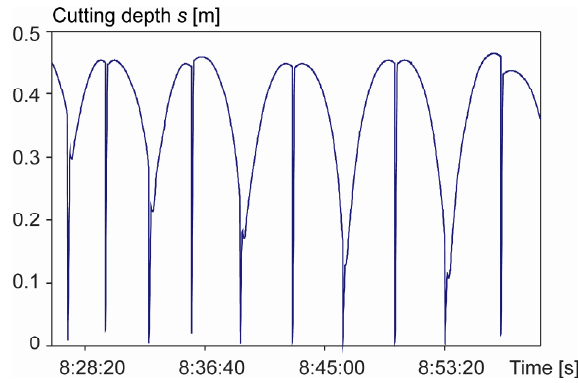
Fig. 11. Cutting depth s vs. mining time